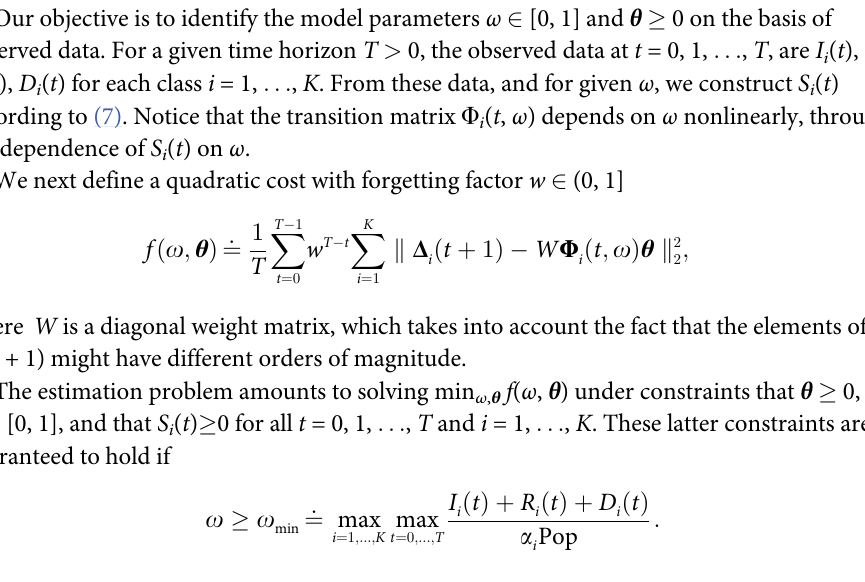
Algorithm 1 ( Estimation of constant parameters